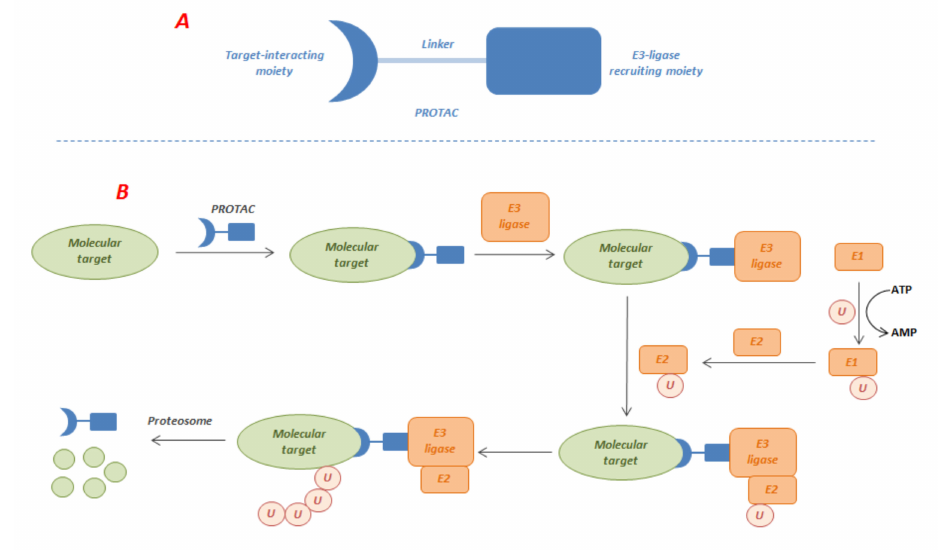
Figure 3. General structure of PROTACs ( A ) and their putative mechanism of action ( B